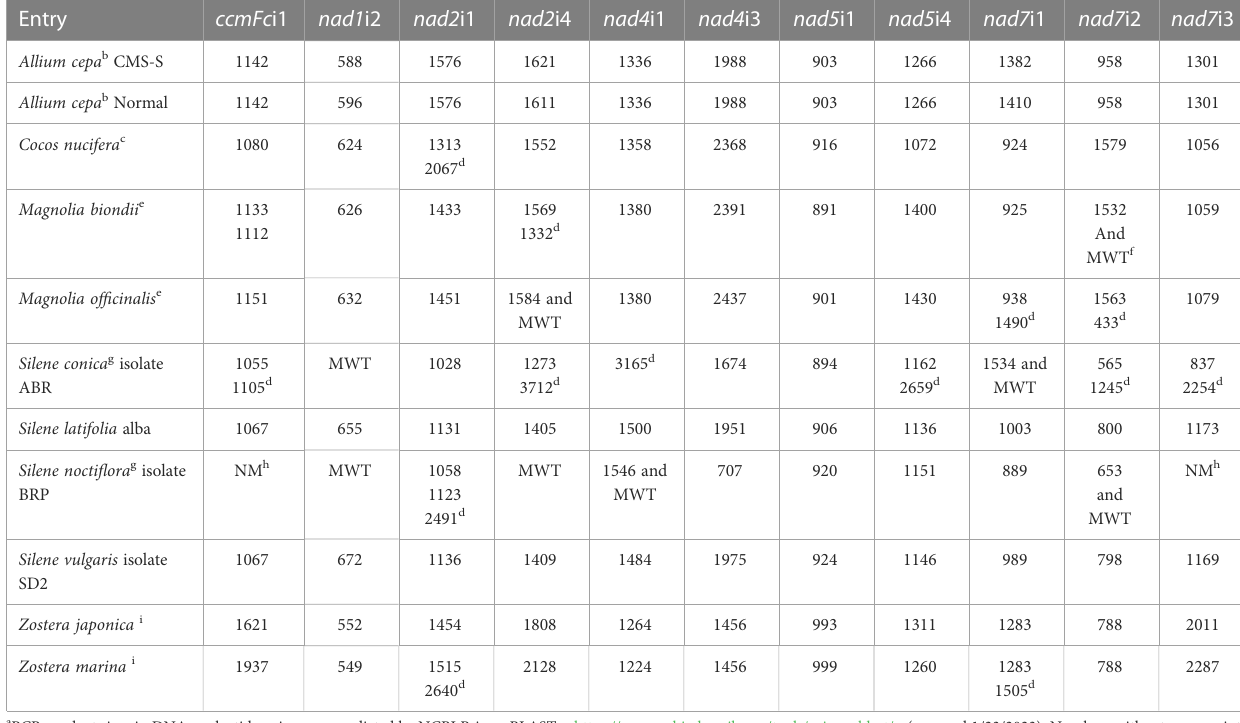
TABLE 4 Intron PCR product length predicted by Primer-BLAST a